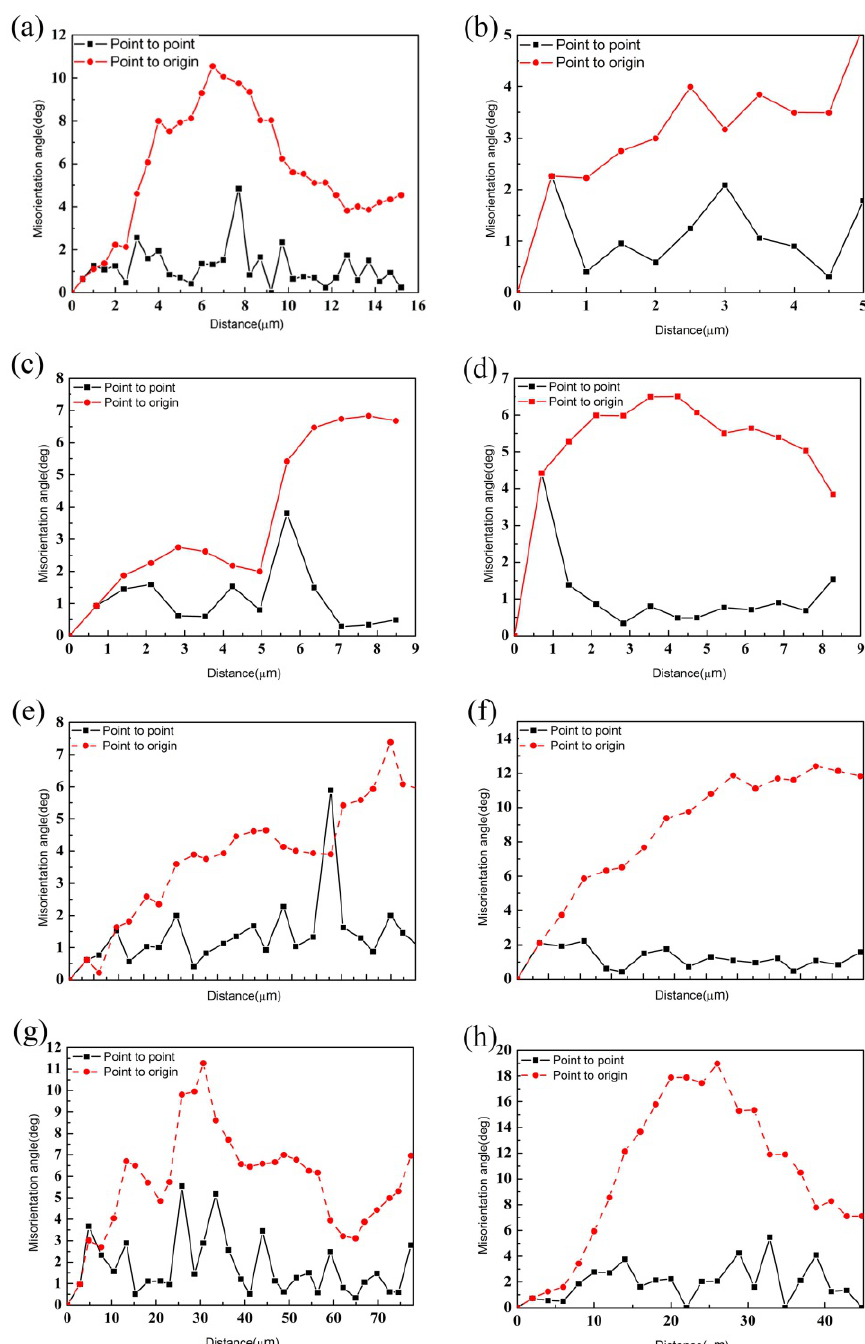
Figure 15. Misorientations measured along the lines marked in Figure 7: ( a ) A1, ( b ) A2, ( c ) B1, ( d ) B2,